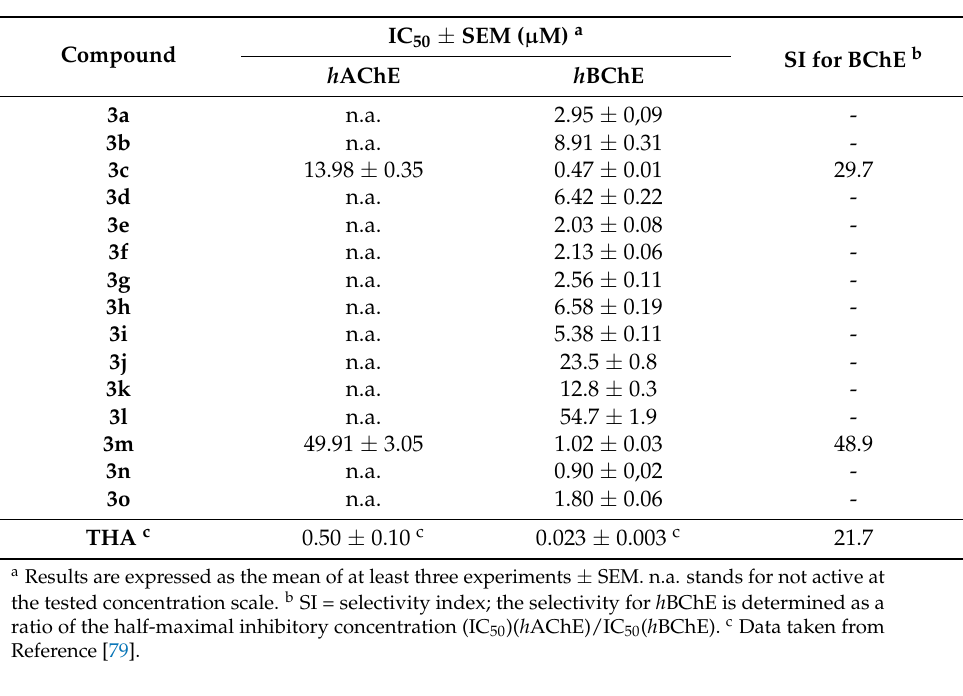
Table 2. The inhibitory activities of compounds 3a – o for human acetylcholinesterase ( h AChE) and human butyrylcholinesterase ( h BChE).